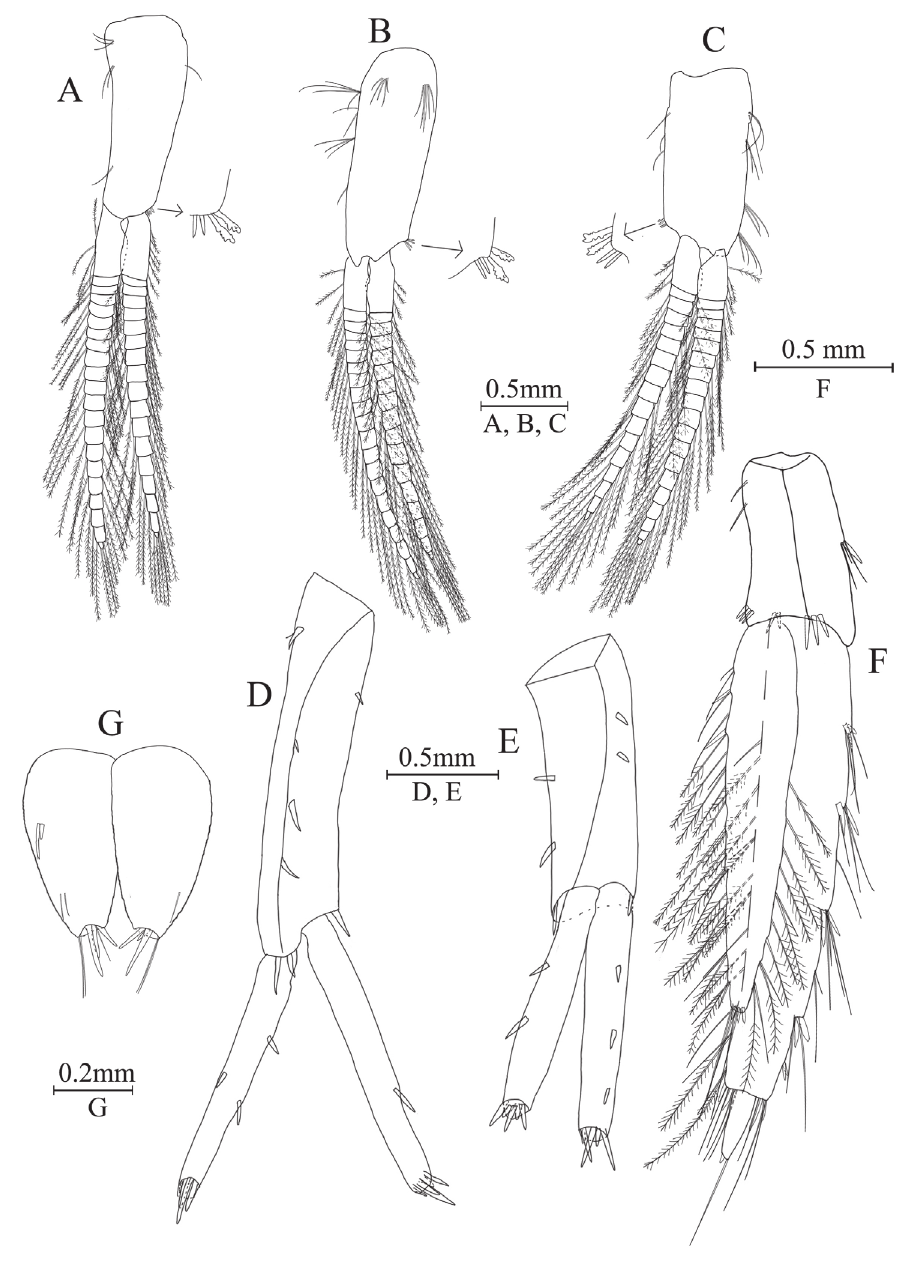
Figure 8. Gammarus zhouqiongi sp. nov. A–F male holotype G female paratype A plepod I B pleopod II C pleopod III D uropod I E uropod II F uropod III G